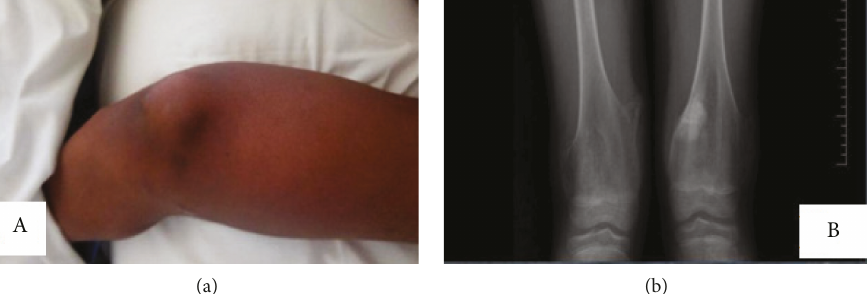
Figure 1: (a) marked swelling and induration of the left distal femur and (b) X-ray shows bone outgrowths (exostoses) on the medial and lateral aspects of the distal femur bilaterally and left metaphyseal widening (AP